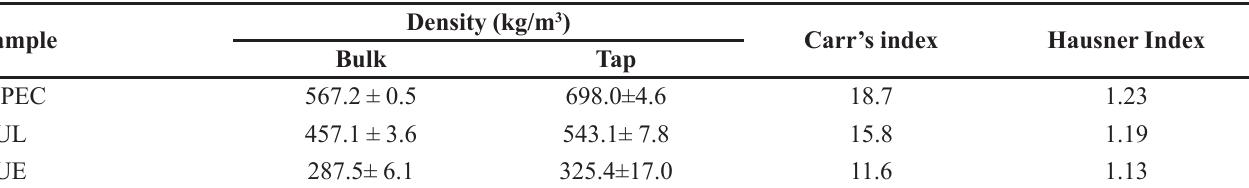
TABLE III - Density and flow properties